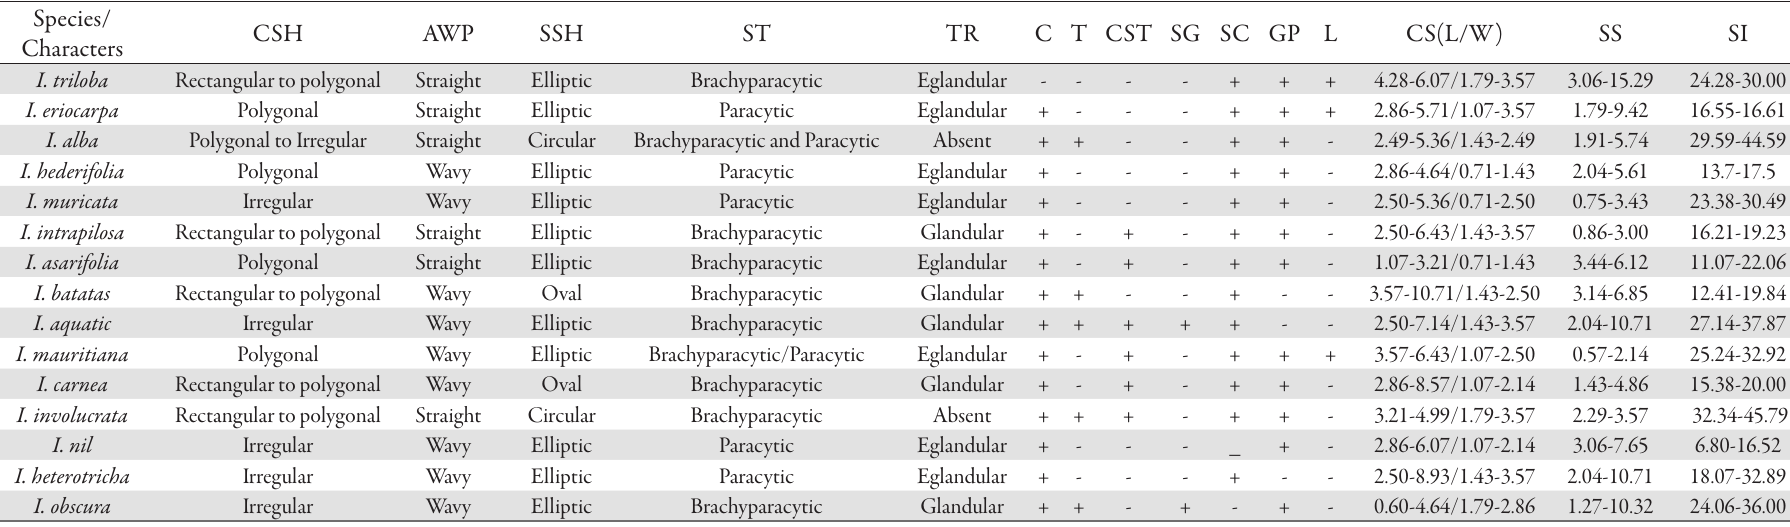
Tab. 2. Abaxial epidermal features of the South Western Nigerian Ipomoea